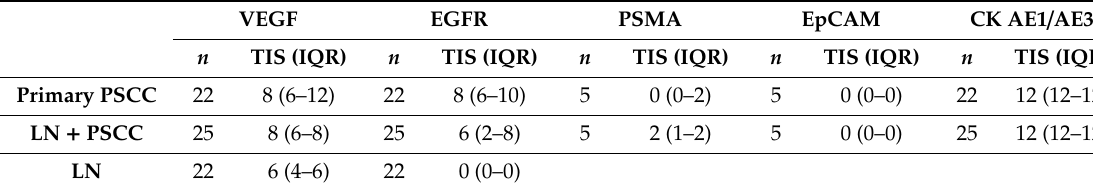
Table 2. Scoring immunoreactivity of all antibodies on PSCC, median (interquartile range) .